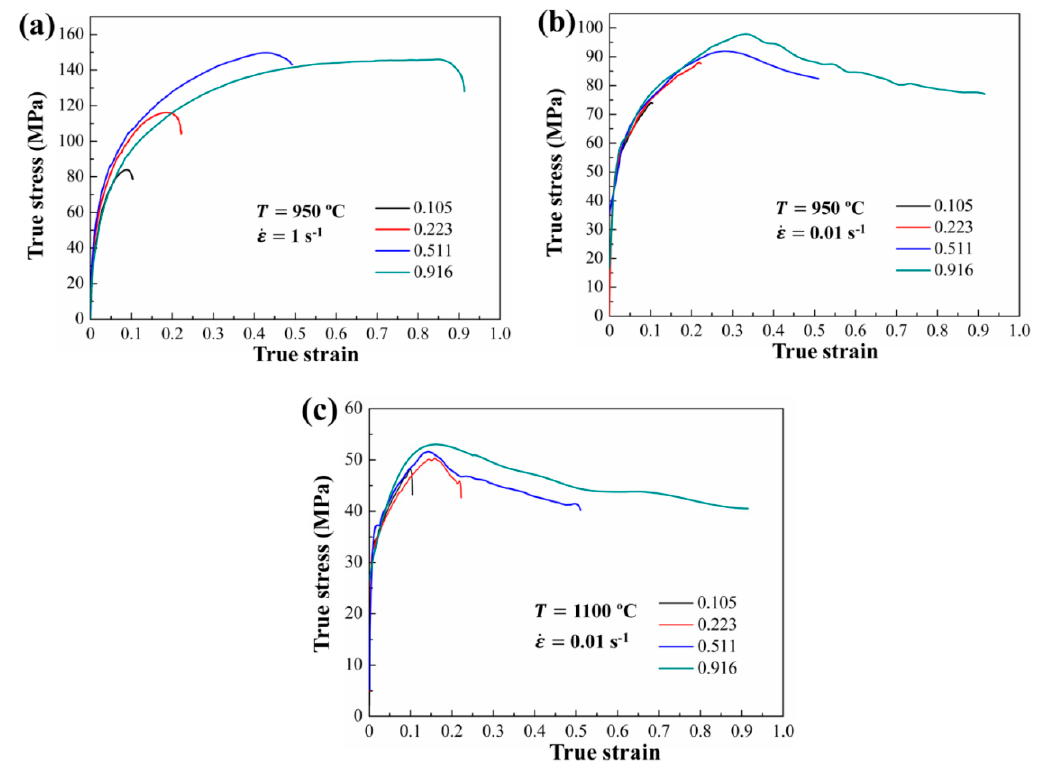
Figure 3. True stress–strain curves of the investigated steel at different deformation parameters: ( a ) T = 950 °C, strain rate = 1 s − 1 , ( b ) T = 950 °C, strain rate = 0.01 s − 1 , ( c ) T = 1100 °C, strain rate = 0.01 s − 1 .